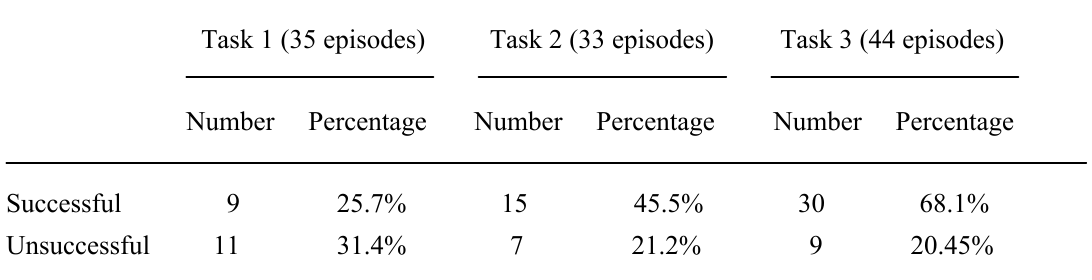
Successful and unsuccessful uptake, by